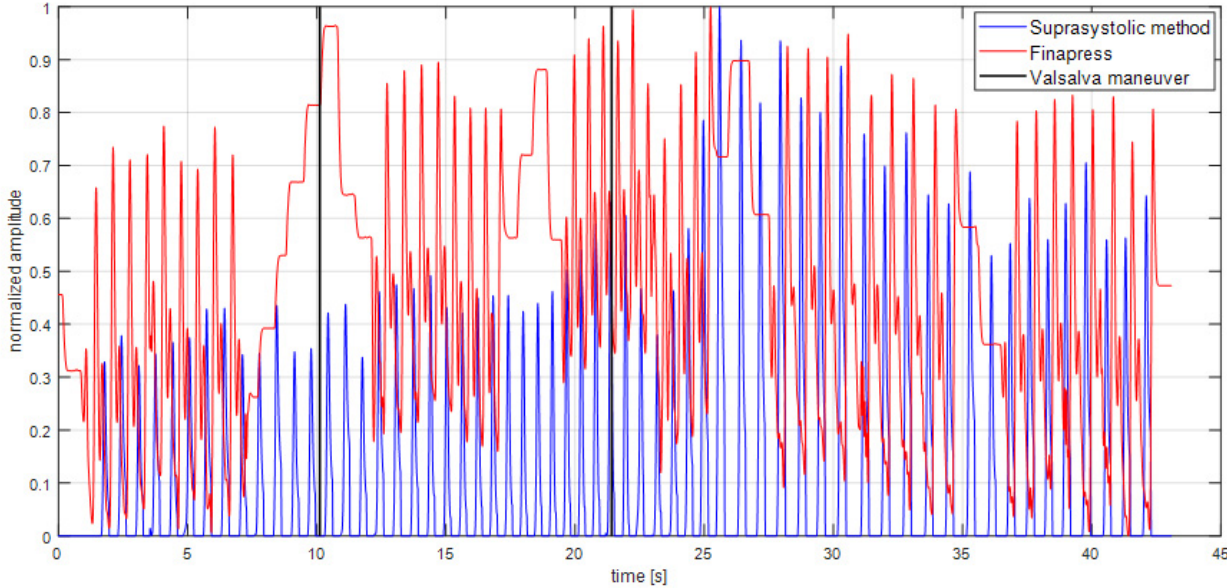
Figure 5. During the measurements, in some cases Finapres had problems with handling the pres- sure changes and measurement of the